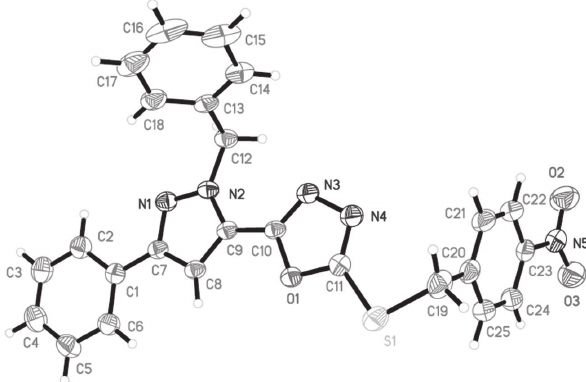
Table 1: Data collection and